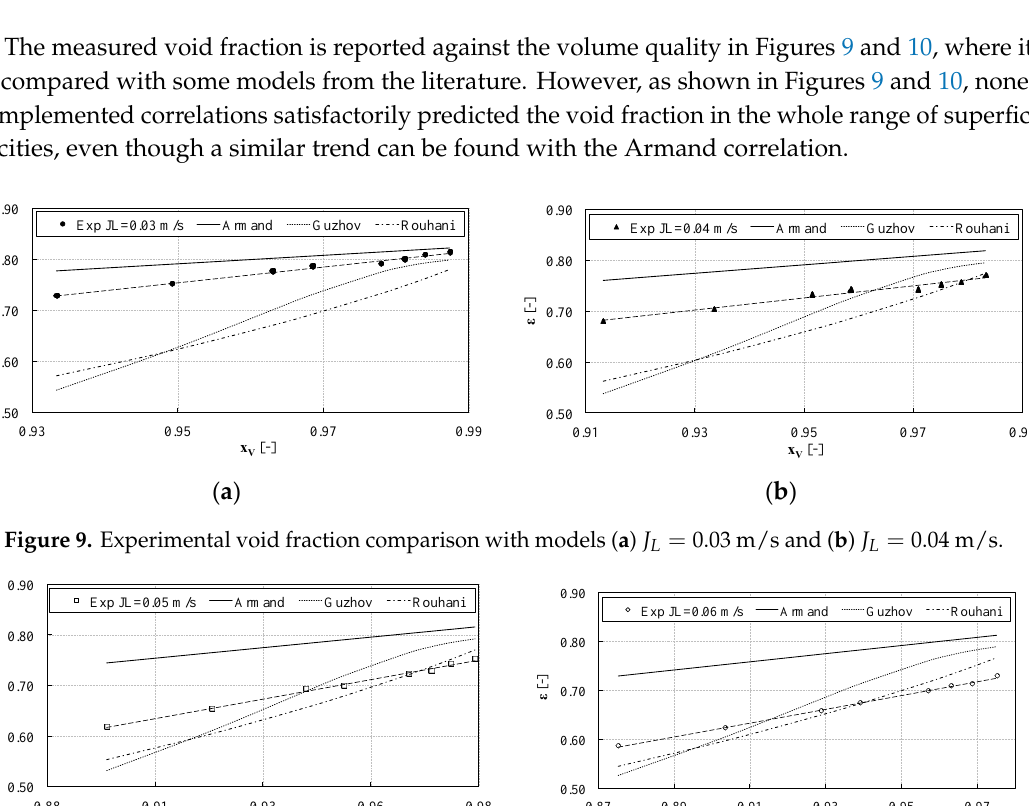
Figure 10. Experimental void fraction comparison with models ( a ) 𝐽 𝐿 = .05 𝑚/𝑠 and ( b ) 𝐽 𝐿 =